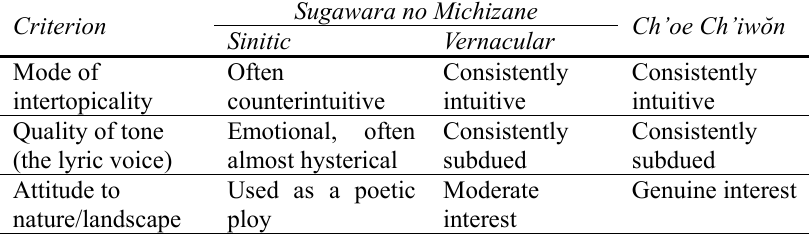
Table 2. A comparative analysis of the Sinitic and vernacular poetics of Sugawara no Michizane and Ch’oe